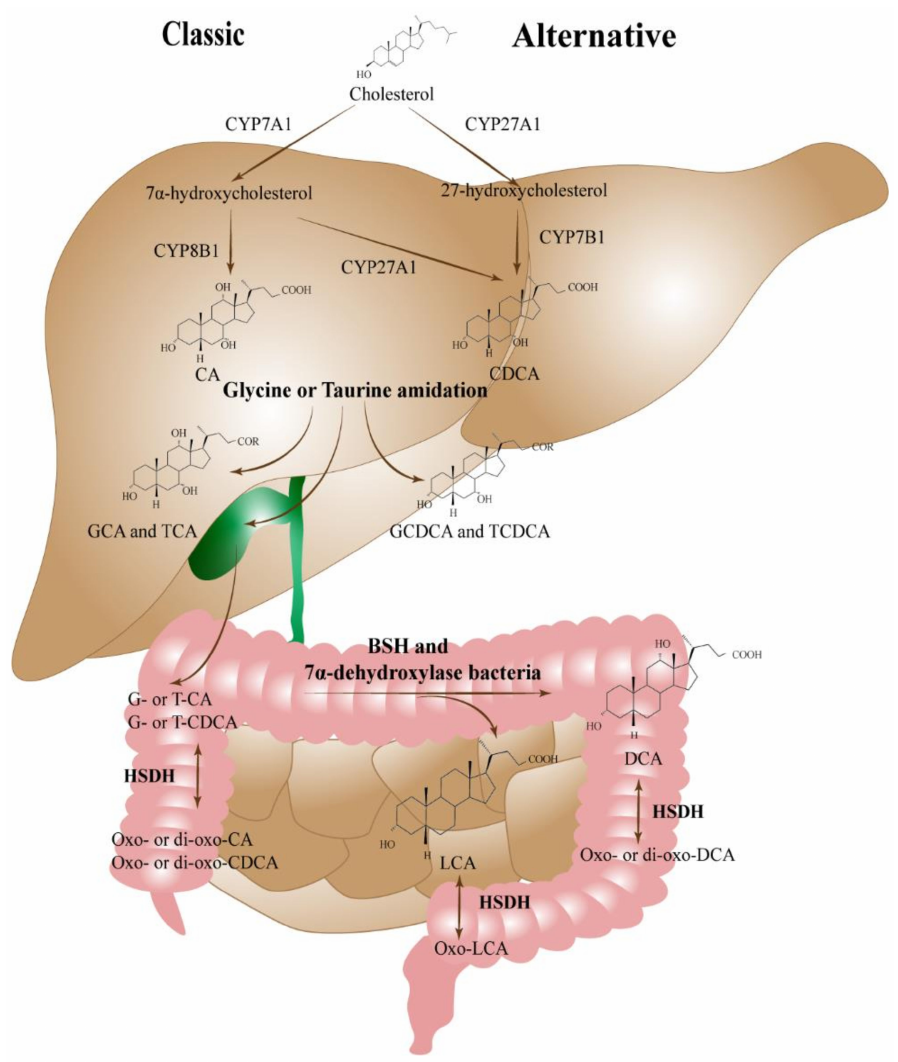
Figure 1. Bile acid